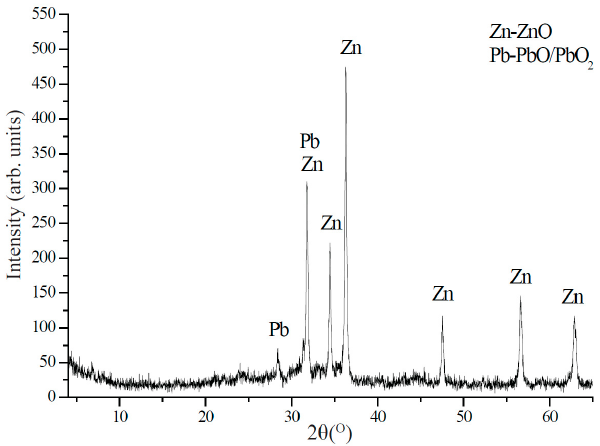
Figure 7. XRD analysis of crude ZnO dust.